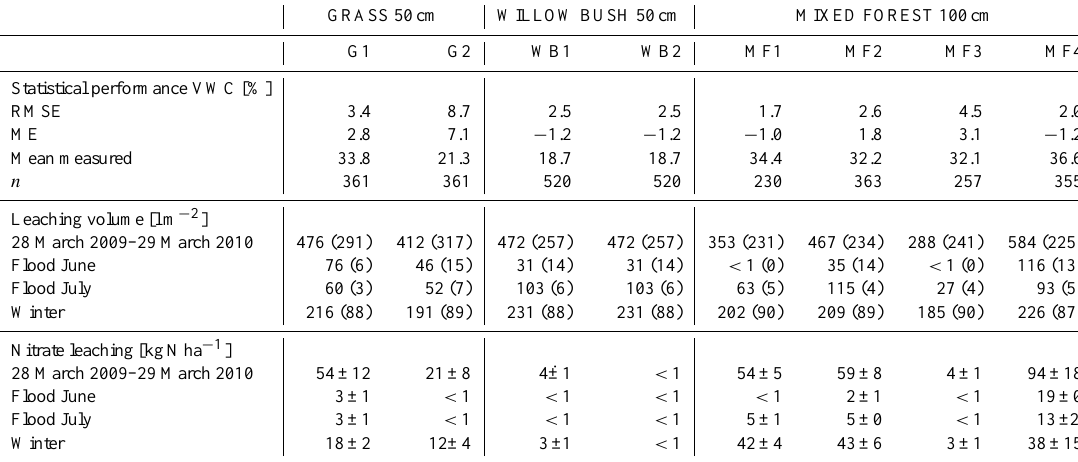
Table 3. (Above) Statistical performance of the modelling of VWC, including the root mean squared error (RMSE), the mean error of estimate (ME), the average of measurements (±std error) between October 2008 and May 2010 and number of measurements ( n ). (Below) Leaching volumes and nitrate leaching for the complete sampling period (28 March 2009–29 March 2010) and during summer floods (16 June 2009